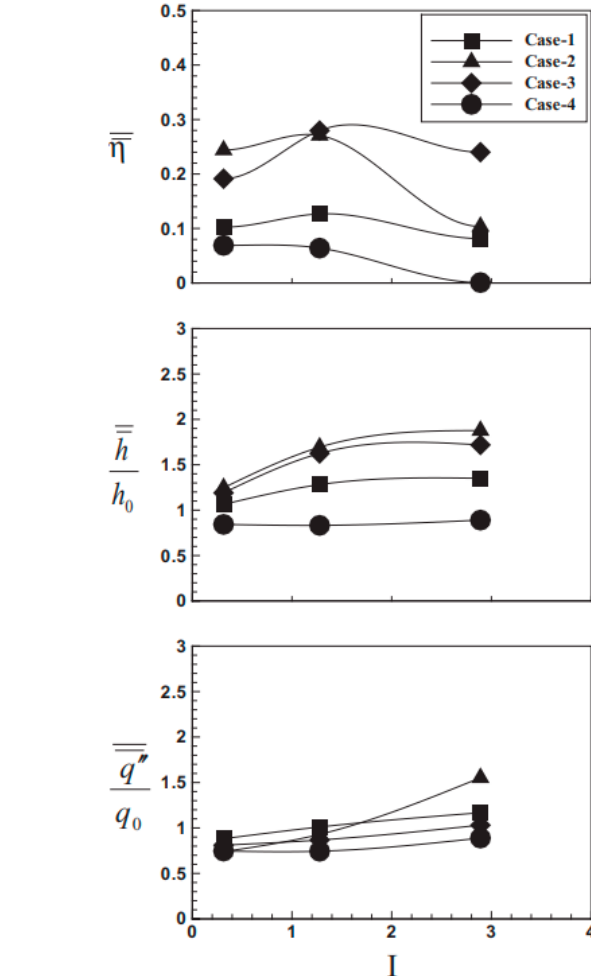
Figure 9. Film cooling with tabs and the effect of momentum flux ratio (I) were presented by Nasir et al. [50]. Heat transfer coefficient and net heat flux reduction trends for the compound holes at different momentum flux ratios were presented by [46].